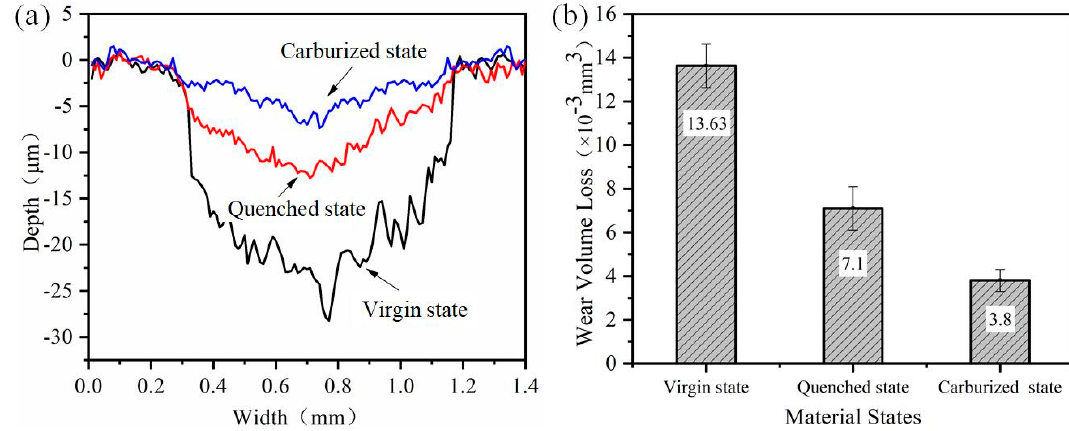
Figure 7. The wear characteristics of 20CrMnTi at different material state: ( a ) cross-section profiles of wear scars and ( b ) wear volume loss (WVL) of specimen.